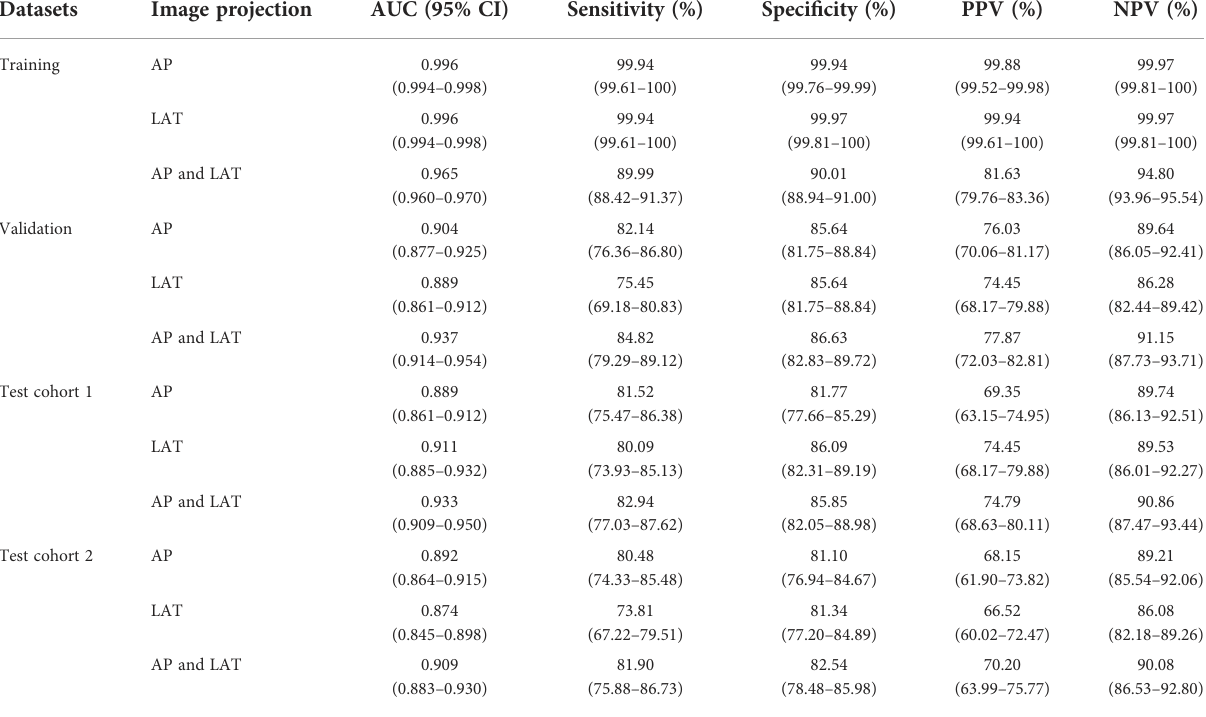
TABLE 2 Performance of the CNN model with images inputting for classifying osteoporosis, assessed on the training, validation, and test cohorts.